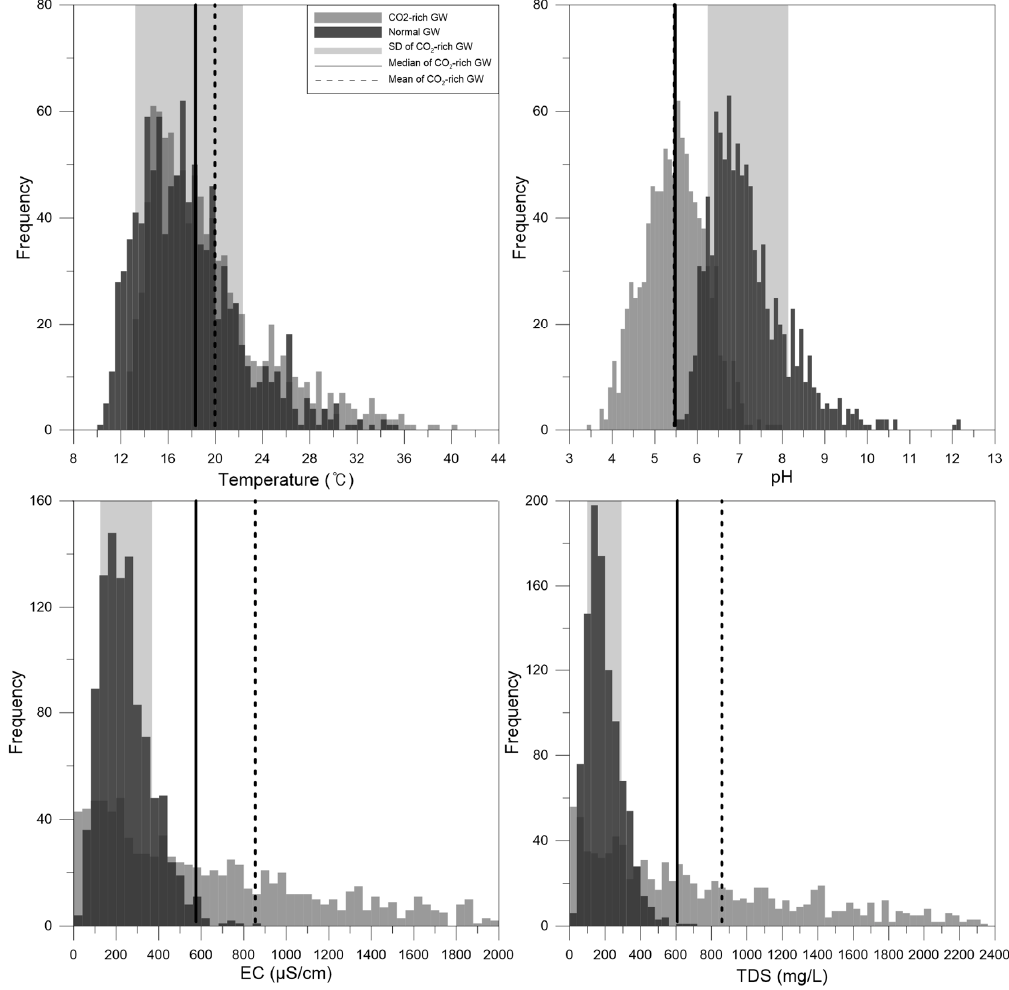
Figure 4. Comparison of temperature, pH, TDS, and EC of CO 2 -rich (gray) and ordinary (dark gray) groundwaters in Chungcheong Province.